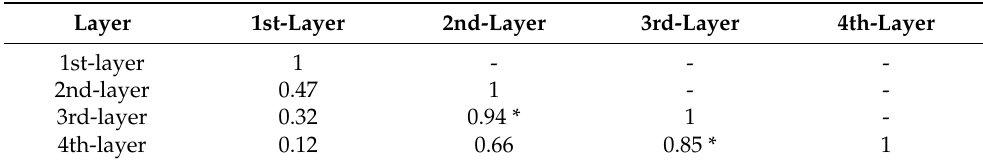
Table 3. Correlation of SPAD values among different vertical layers (R 2